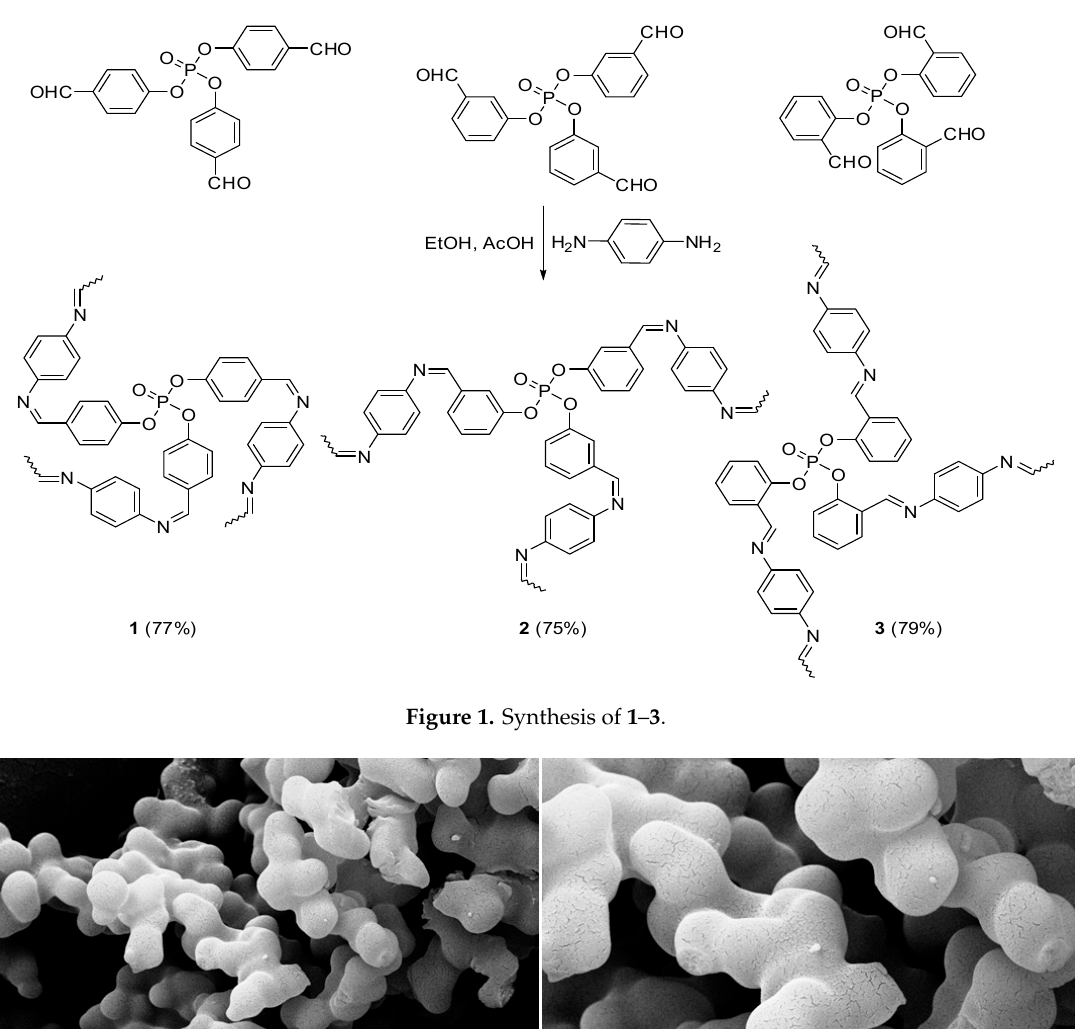
Table 1. Physical properties of 1–3 . Figure 2. Field emission-scanning electron microscope (FESEM) images of 1 . Figure 2. Field emission-scanning electron microscope (FESEM) images of 1 . Figure 2. Field emission-scanning electron microscope (FESEM) images of 1 .